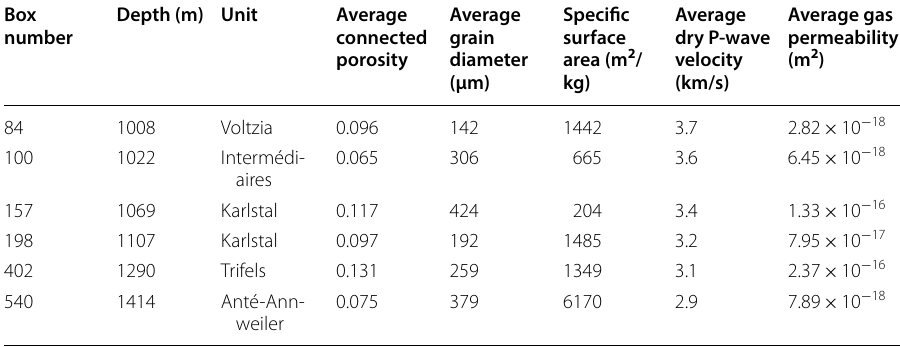
Physical property data taken from Heap et al. (2017). Elastic wave velocities and porosities were measured at room pressure and permeabilities were measured under a confining pressure of 1 MPa (see Heap et al. (2017) for